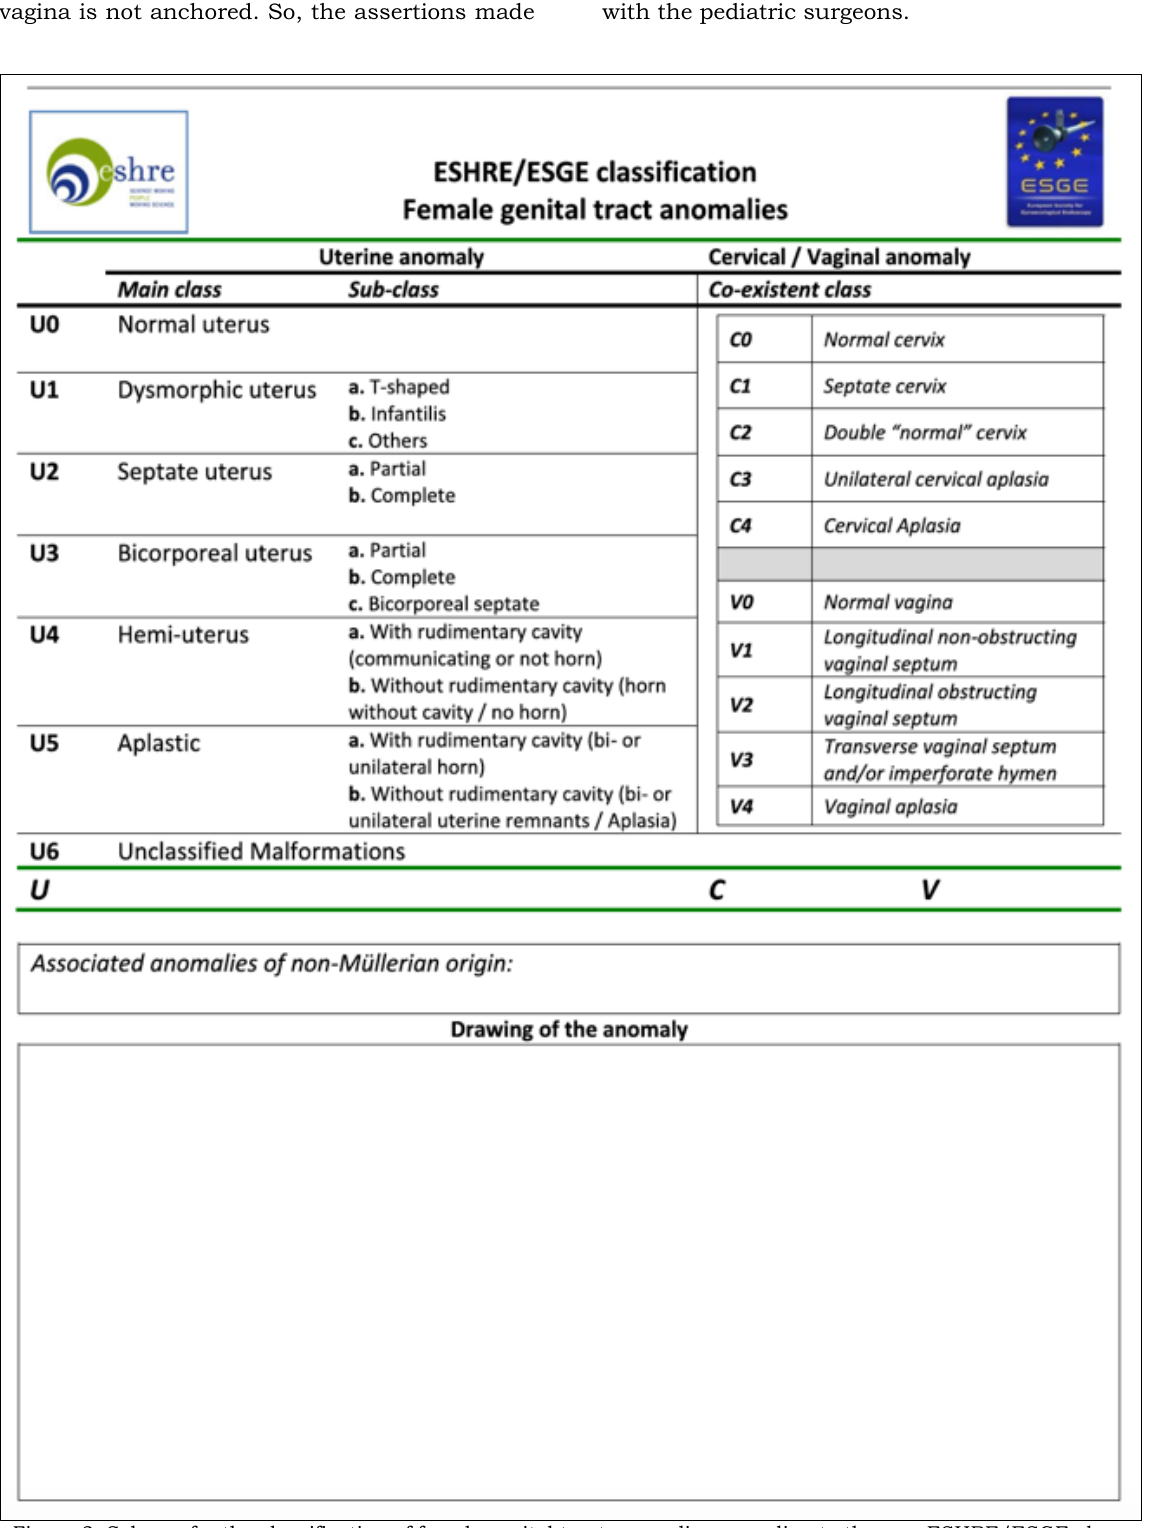
Figure 2: Scheme for the classification of female genital tract anomalies according to the new ESHRE/ESGE clas- sification system (Reproduced with permission from Grimbizis et al. Hum Reprod.